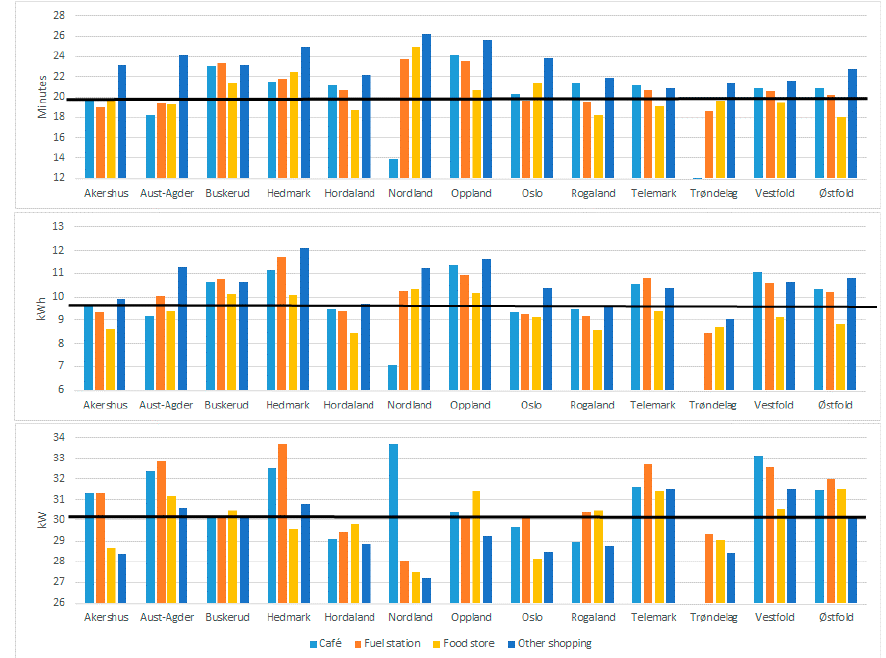
Figure 16. Variation in the minutes spent charging ( top ), the kWh charged ( middle ) and the average charge power ( bottom ) between different charging location categories and Counties. Source: Dataset 1 and own analysis.